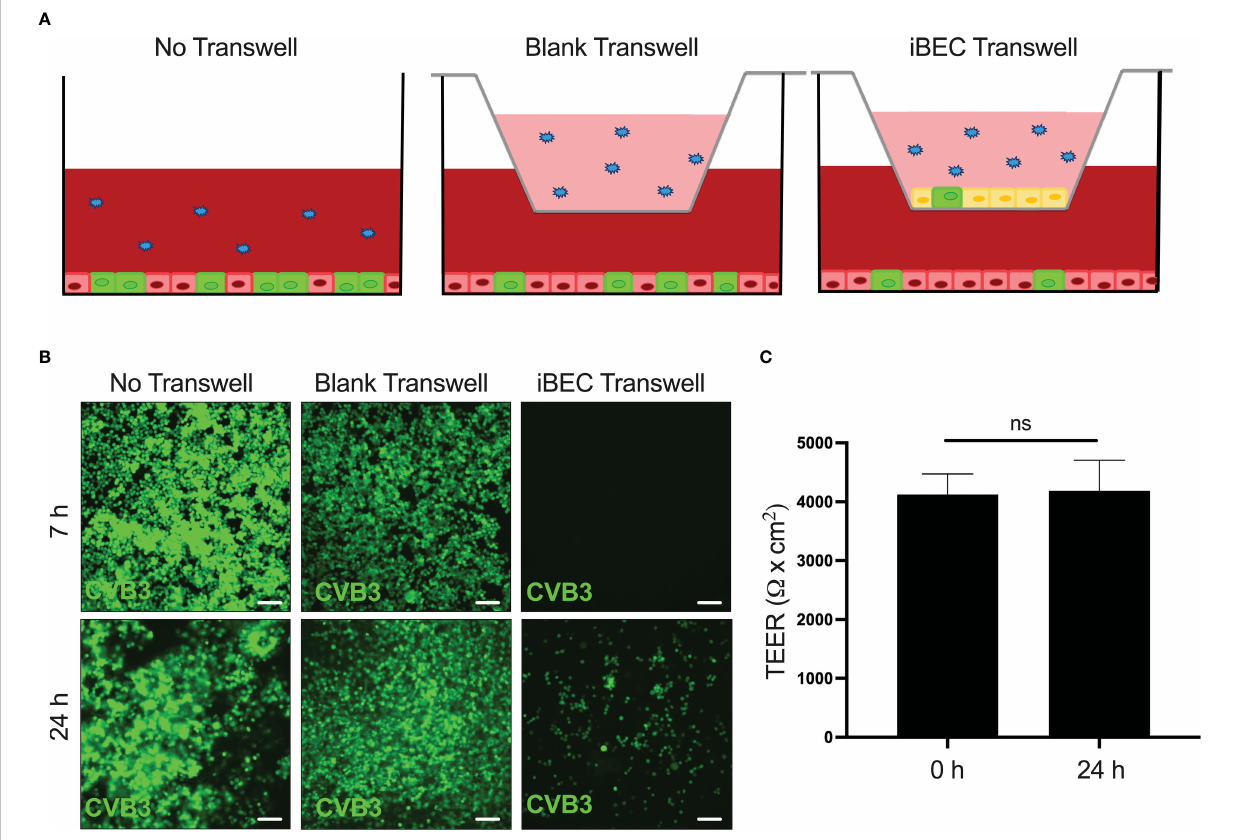
FIGURE 5 iBECs transiently protect permissive cells from infection iBECs were seeded in transwells and overlain above monolayer of permissive HeLa cervical cancer cells. iBECs were then infected with eGFP-CVB3 at MOI 10 with the viral inoculum added into the top of the transwell. (A) Schematic of experimental setup also detailing “ No Transwell ” and “ Blank Transwell ” control conditions. (B) Fluorescence microscopy images of HeLa cells (below transwells) detecting viral eGFP at indicated timepoints. Scale bars= 100 m m. (C) TEER measurements of iBEC-seeded transwells prior to infection and 24 h post-infection with eGFP-CVB3 at MOI 10. (ns, not signi fi cant, p>0.05; student ’ s t-test; n=3. Error bars represent standard